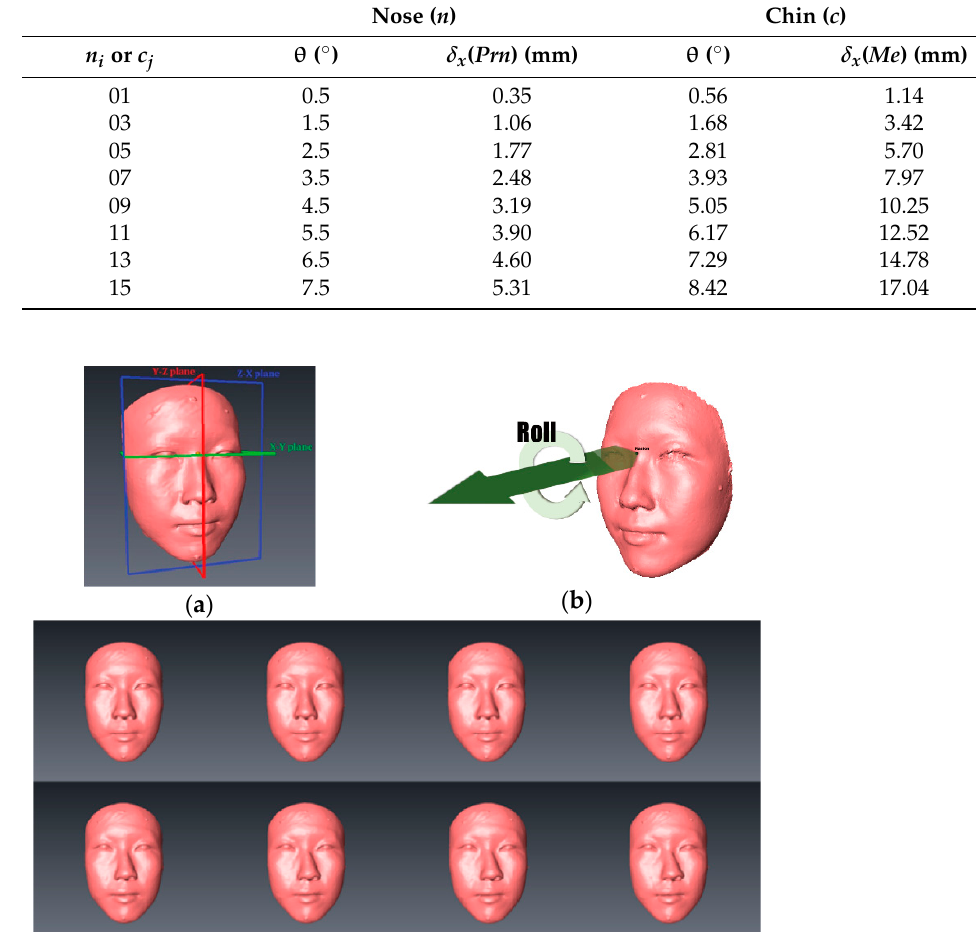
Table 2. Roll rotations of the nose and the chin.